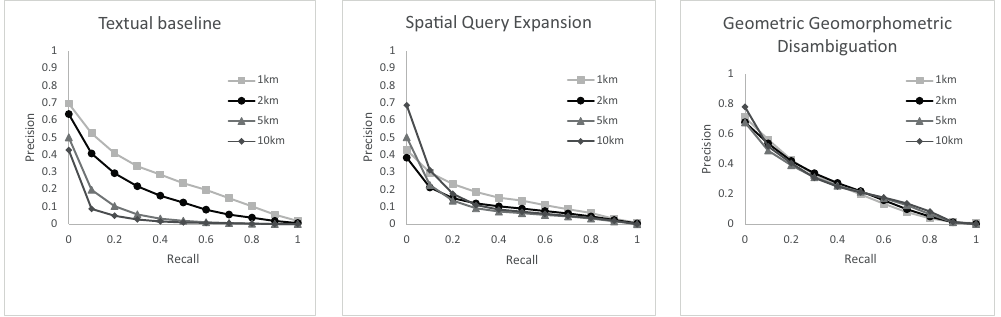
Figure 10: Precision-recall curves for the three GIR